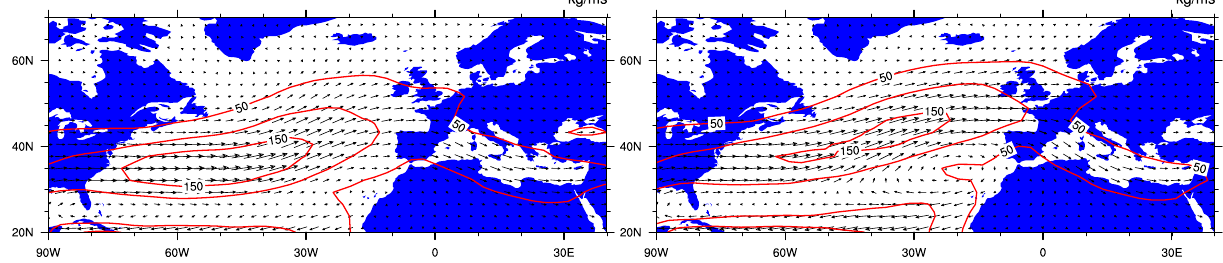
Fig. 5. Average vertically integrated moisture (in kgkg − 1 ) transport vectors for winters with low or negative (left) and high (right) EOF time series. Red contour lines correspond to vector magnitudes.